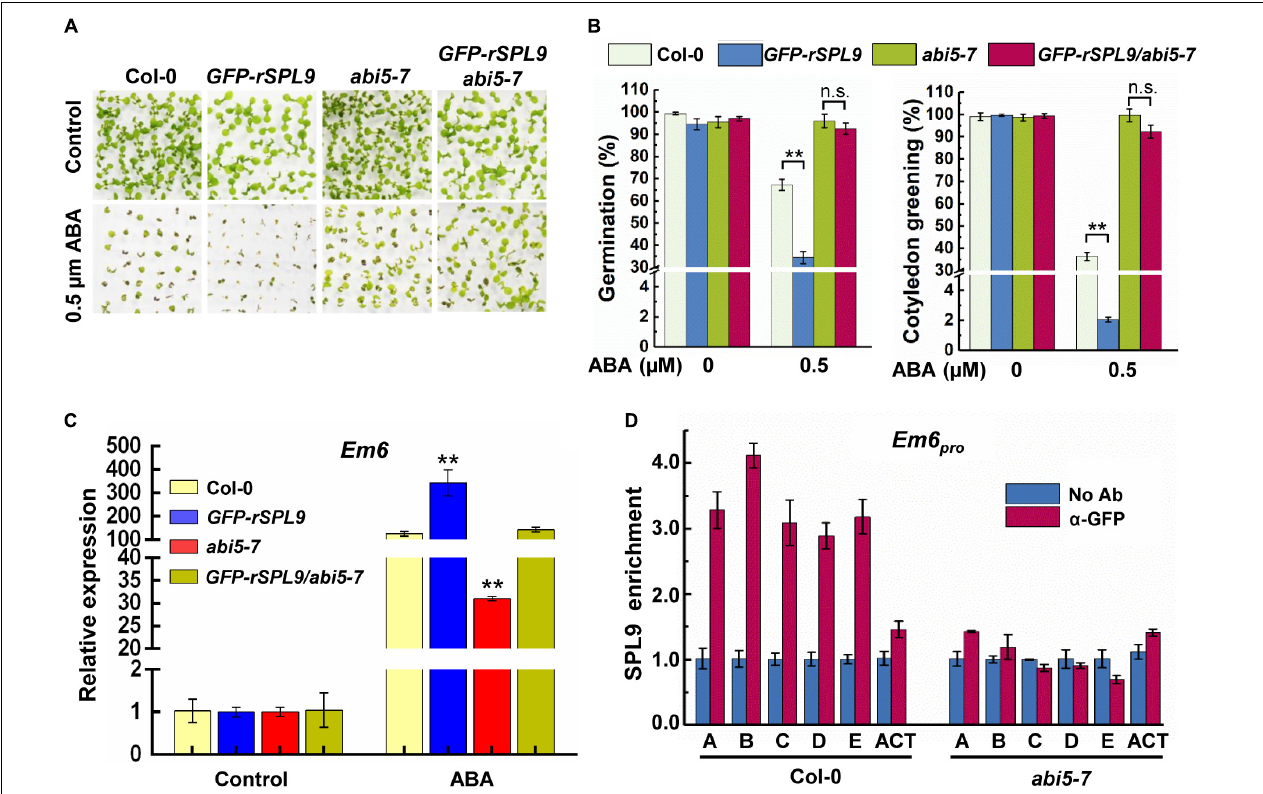
FIGURE 3 | SPL9 promotes ABA responses in an ABI5-dependent manner. (A) Germination phenotypes of the indicated seedlings grown on medium without or with 0.5 µ M ABA for 7 days. (B) Quantification of seed germination and cotyledon greening of indicated genotypes in response to ABA. Seed germination percentage was recorded at 3 days after the end of stratification. Cotyledon-greening percentage was recorded at 5 days after the end of stratification. Data shown are mean ± SD ( n = 3). At least 100 seeds per genotype were measured in each replicate. ** P < 0.01, n.s. indicates no significant difference (Student’s t -test). (C) qRT-PCR assays showing the expression levels of ABA-responsive gene in the indicated genotypes with ABA treatment. The 4-day-old seedlings were treated without or with 10 µ M ABA for 4 h. The expression levels of Em6 in untreated seedlings (Control) for each genotype were set to one. Data are means ± SD ( n = 3). ** P < 0.01 (Student’s t -test). (D) ChIP-qPCR assays showing that the ABA-triggered enrichment of SPL9 on the Em6 promoter is dependent on ABI5. The 6-day-old GFP-rSPL9 and GFP-rSPL9/abi5-7 seedlings treated with 50 µ M ABA for 2 h were harvested for ChIP assays. Error bars denote ± SD ( n = 3). ACT7 was used as